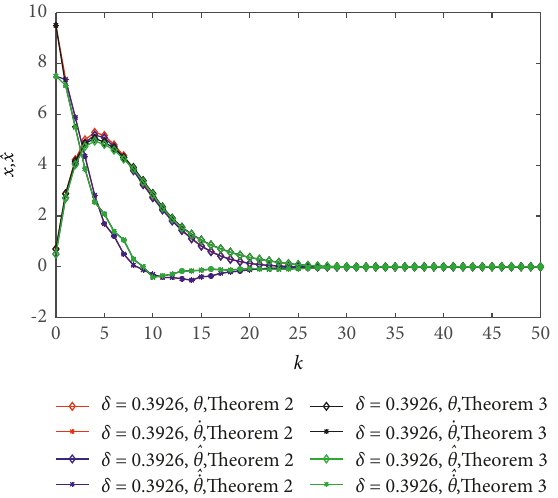
Figure 4: State and estimated state with δ � 0 . 3936.